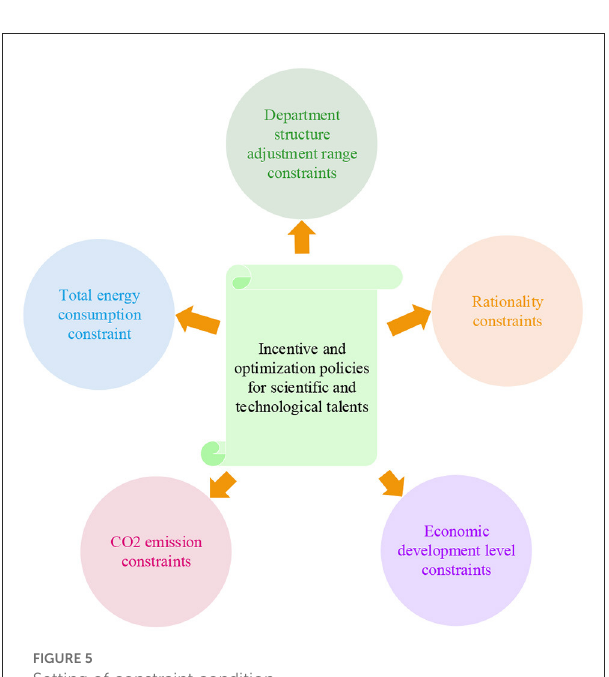
FIGURE5 Setting of constraint condition.